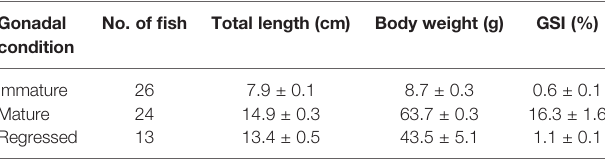
TABLE 1 | Total length, body weight and gonadosomatic index (GSI) of fi sh samples. Values are presented as mean ± SEM. Gonadal